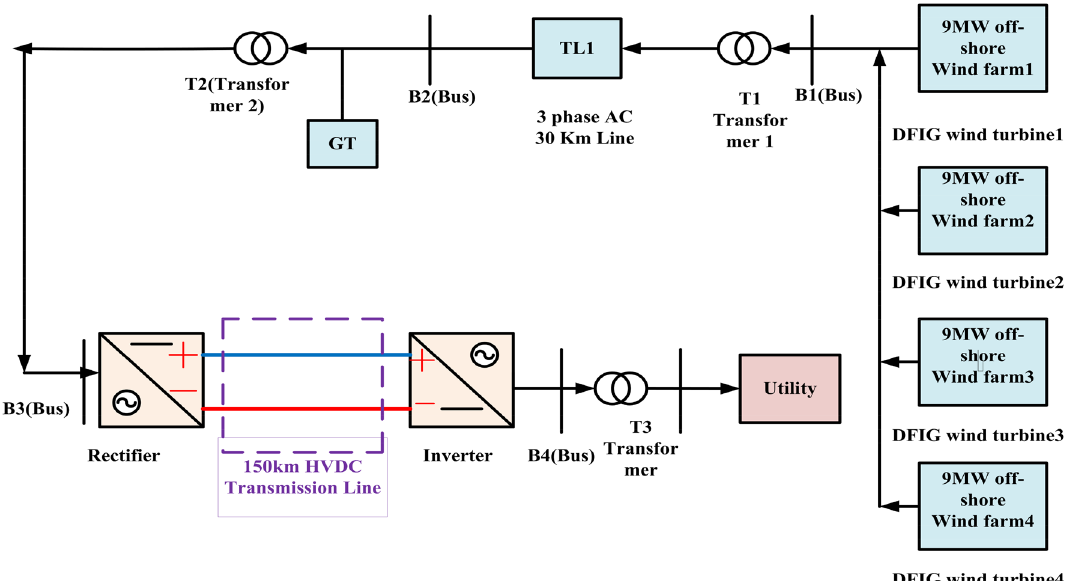
Fig. 1 Single line diagram of VSC based HVDC system fed by the integrated offshore wind farm